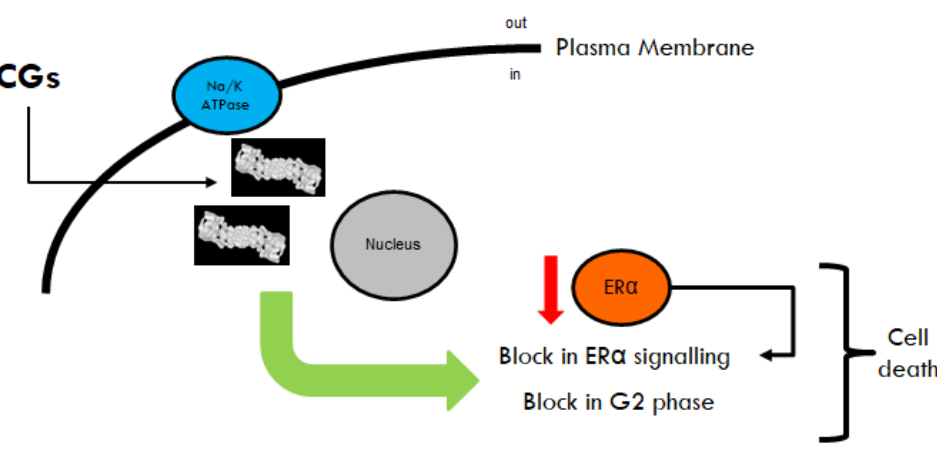
Figure 10. Proposed model for ouabain and digoxin functions in BC cells. Schematic description of the proposed mechanism of ouabain and digoxin (i.e., cardiac glycosides-CGs) in breast cancer cells. A detailed description of the various steps is provided in the main text.